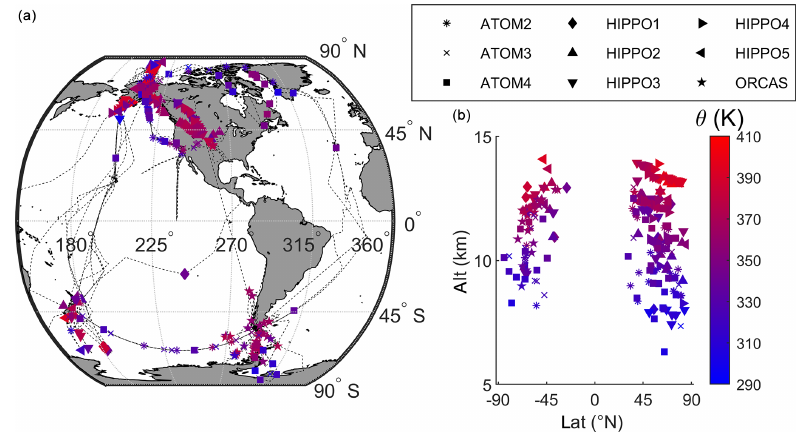
Figure 1. Horizontal (a) and vertical (b) distributions of airborne flask sample locations identified as being of stratospheric origin (see text). Thin dashed black lines on the map illustrate the flight tracks of all nine campaigns. Symbols indicate the campaigns during which the stratospheric samples were collected, and colors show the potential temperature at which the sample was taken.